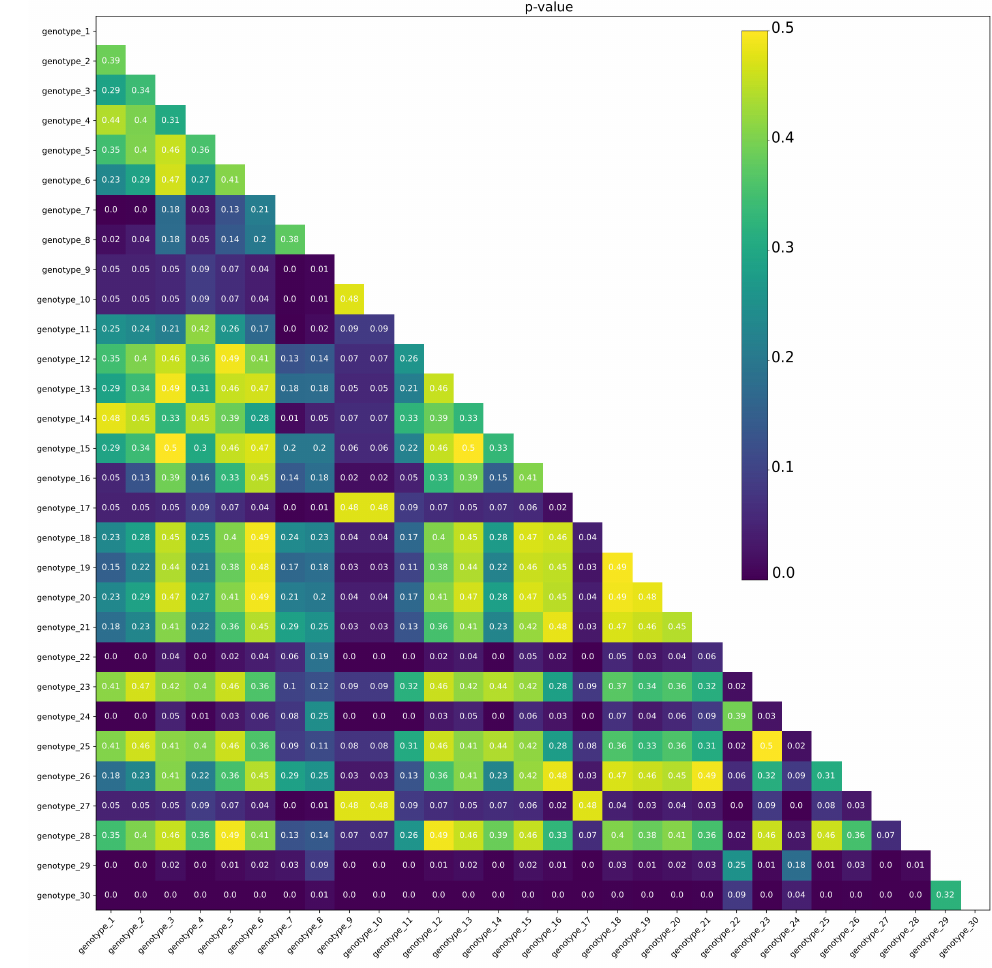
Figure 8. The comparison of genotypes by reached fitness u (2). Pairs with statistically significant difference are marked in dark